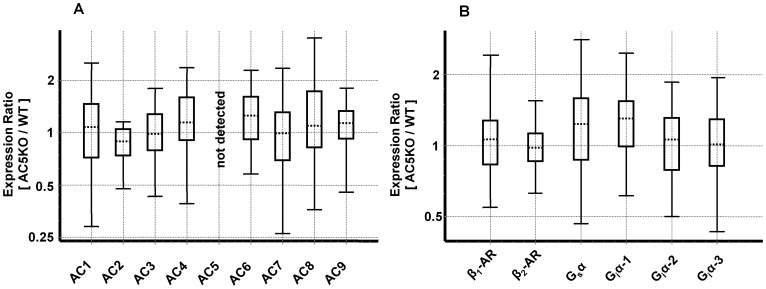
mRNA expression analysis of the β-AR-G-protein-AC signaling cascade in mouse hearts.Box and whisker plots show the gene expression ratios in left ventricles (LVs) from AC5KO- relative to that in WT mice obtained from qRT-PCR experiments described under Methods. (A) Relative mRNA expression of membranous ACs 1–9. AC5 mRNA was not detected in LVs from AC5KO hearts. (B) Relative mRNA expression of β-ARs 1 and 2, Gsα and Giα 1–3. The lower and upper boundaries of the boxes represent the 25th percentile and the 75th percentile. The line within the boxes represents the median. The whiskers show the lower and upper 25% of observations. Data of each target (A and B) was obtained from qRT-PCR experiments with seven WT- and five AC5KO heart LVs performed in duplicates. There were no significant differences in the gene expressions of investigated targets between LVs from WT vs. AC5KO mice except for AC5.